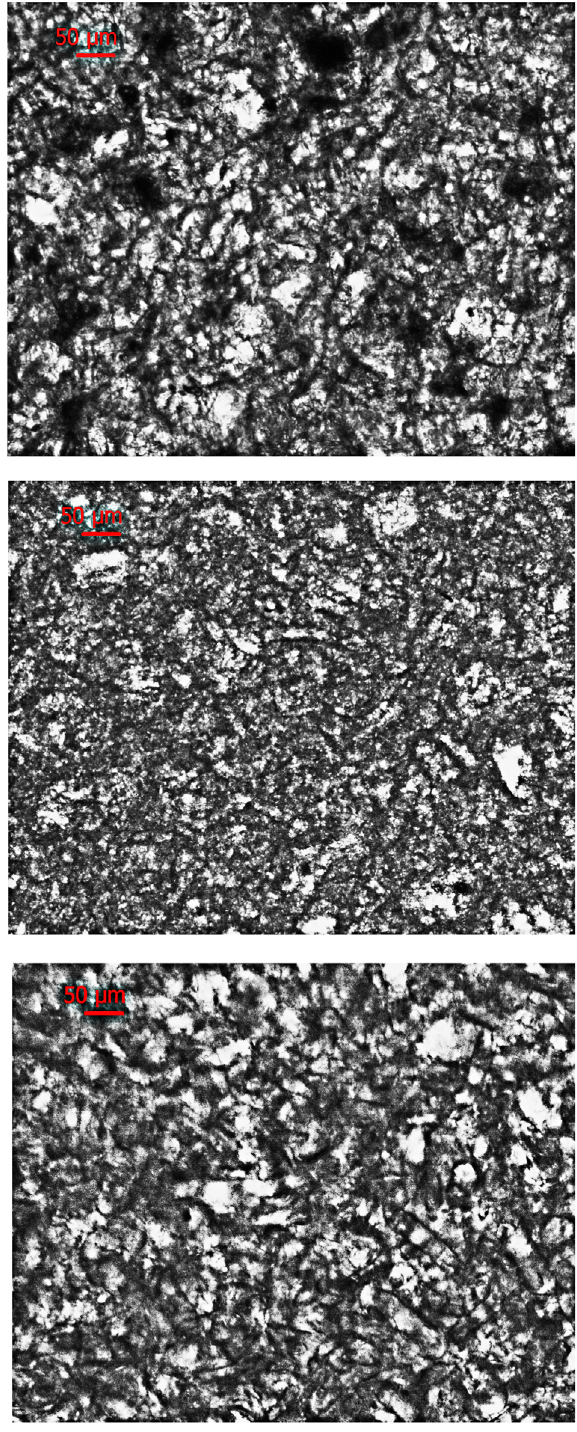
Figure 4- Microscopic images at 5× magnification of adhesive materials under reflectance illumination mode. In Corega cream (upper) we see the sodium-calcium poly(methyl-vinyl-ether/ maleic anhydride) mixed salt in cellulose gum with lots of voids. In Olivafix cream (middle) we see the calcium/sodium poly(vinyl- methyl-methacrylate) copolymer in cellulose gum and in Fittydent cream (lower) agglomerations of silica particle in polyvilylacetate and sodium